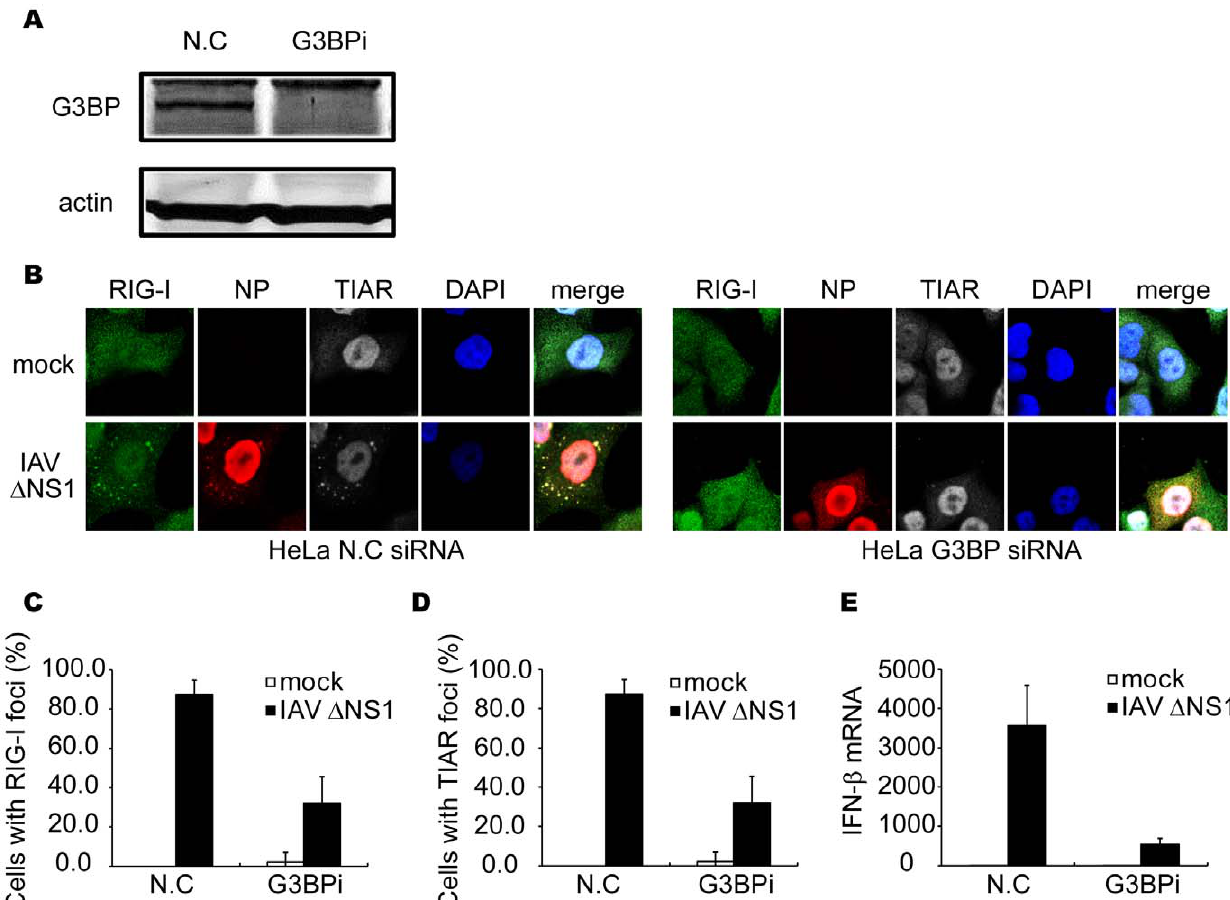
Figure 4. Knockdown of G3BP impairs formation of avSG and IFN-aˆ gene activation. ( A–E ) HeLa cells were transfected with control siRNA (N.C) or siRNA targeting human G3BP (G3BPi). At 48 h after transfection, cells were harvested and G3BP and actin were detected by immunoblotting ( A ). Cells were mock-treated (mock) or infected with IAVA¨NS1 for 12 h and fixed and stained with anti-RIG-I, anti-NP and anti-TIAR antibodies and DAPI ( B ). The percentage of cells containing foci of RIG-I ( C ) or TIAR ( D ) was determined. Relative mRNA level of IFN-aˆ was determined by qPCR ( E ). Data are represented as the mean standard 6 error of the mean (SEM).